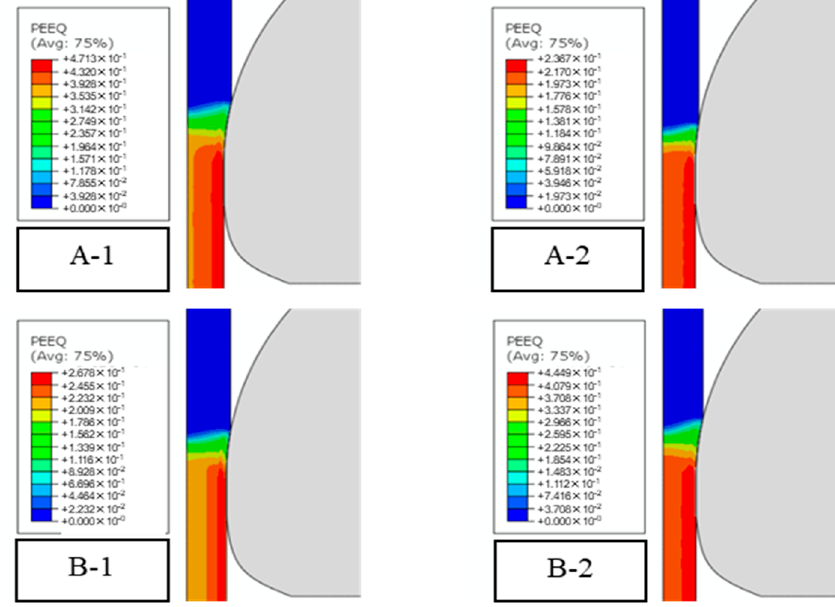
Figure 9. Axisymmetric cloud diagrams of equivalent plastic strain distribution in wires.